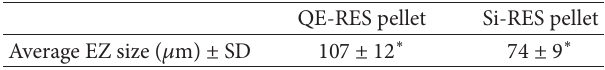
Table 1: EZ width, measured with carboxylate microspheres across the QE-RES and Si-RES pellet interface ( 𝑛 = 4 different pellet samples; ∗ indicates 𝑝 value ≤ 0.1).